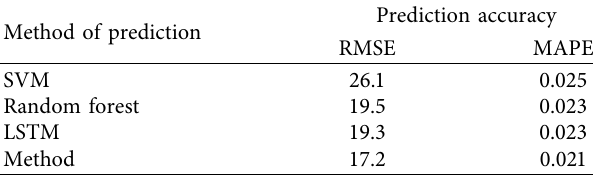
Table 2: Workday power load forecast results.